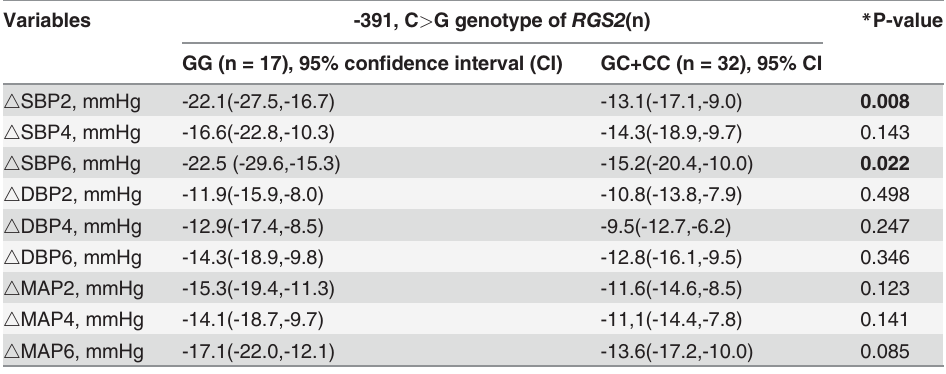
* P-values with the Bonferroni adjustment and BMI, gender, age adjustments were used in the model. 4 SBP2, 4, 6 = SBP change from baseline at the end of 2, 4, and 6 weeks, respectively; 4 DBP2, 4 DBP4, and 4 DBP6 = DBP change from baseline at the end of 2, 4, and 6 weeks, respectively; 4 MAP2, 4 MAP4, and 4 MAP 6 = MAP change from baseline at the end of 2, 4, and 6 weeks, respectively.